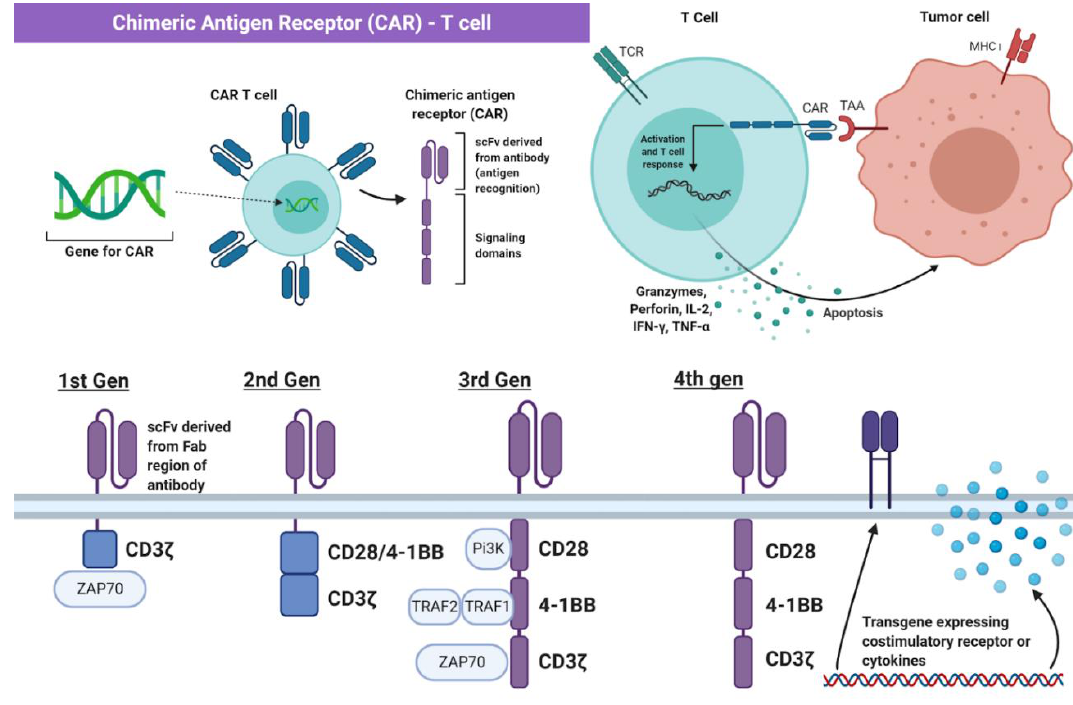
Figure 2. The Chimeric Antigen Receptor T cell (CAR-T Cell). The chimeric antigen receptor (CAR) construct is inserted into T cells and enables initiation of apoptosis via binding to tumor-specific or tumor-associated antigens independent of MHC interaction. Part of the figure adapted from “Chimeric Antigen Receptor (CAR)” and “CAR-Engrafted T cell and Tumor Cell”, by BioRender.com (2021). Retrieved from https://app.biorender.com/biorender-templates (accessed on 28 February